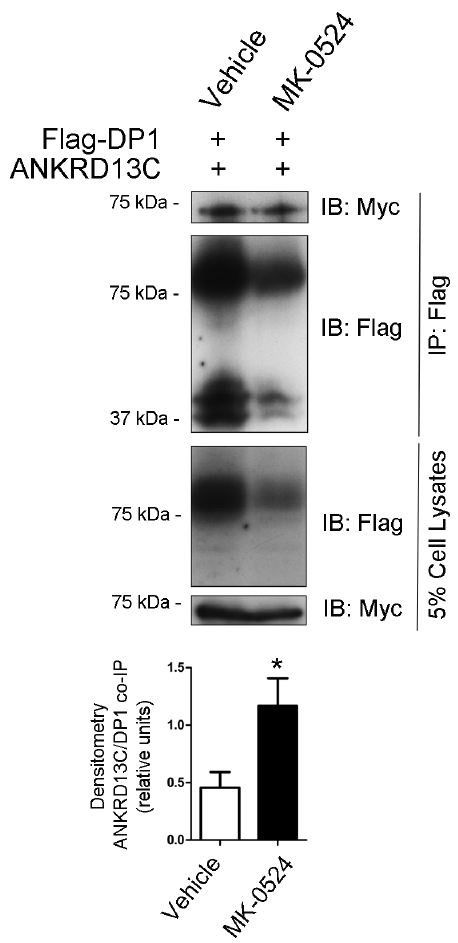
Figure 9. MK-0524 promotes the interaction between DP1 and the ANKRD13C protein. HEK293 cells transiently co-expressing Flag- DP1 and ANKRD13C-myc were treated with vehicle (ethanol) or 1 m M MK-0524 for 24 h. Flag-DP1 was immunoprecipitated as described under ‘‘Materials and Methods’’ and immunoprecipitated samples as well as cell lysates were analyzed by Western blot with anti-Flag and anti-Myc antibodies. The blots shown are representative of three separate experiments. The ratio of the amount of ANKRD13C that was co-immunoprecipitated on the quantity of receptor immunoprecipitat- ed was calculated by densitometry analyses from the three separate experiments and the results are shown in the bottom panel as the mean 6 S.E. * is P ,